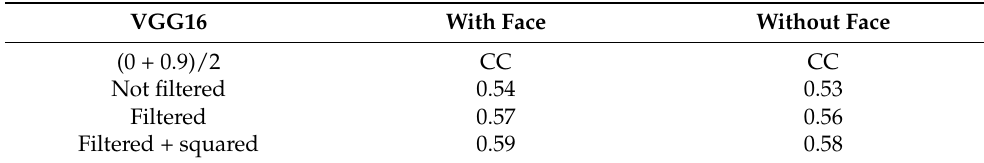
Table 3. The OSIE dataset. Tests on threshold 0 and 0.9 by considering the saliency map without filtering, with filtering, and with filtering and squared.